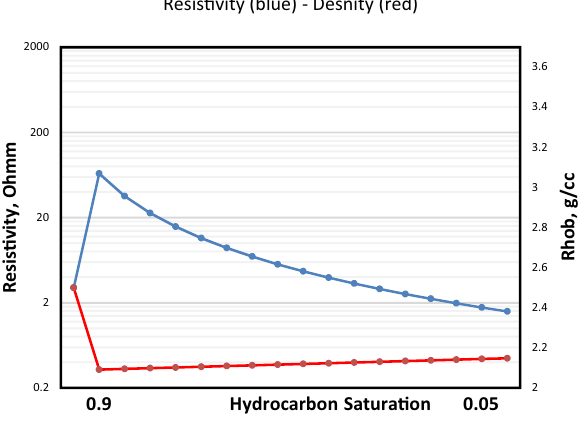
Fig. 10 Density–resistivity overlay, clay = 25%, m =